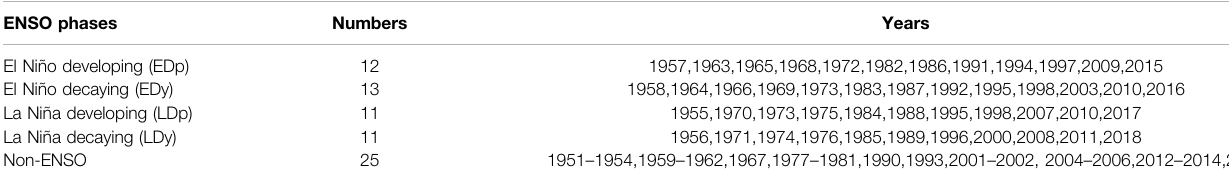
TABLE 1 | Classi fi cation of the summers during 1951 – 2019 into the fi ve ENSO phases. ENSO phases